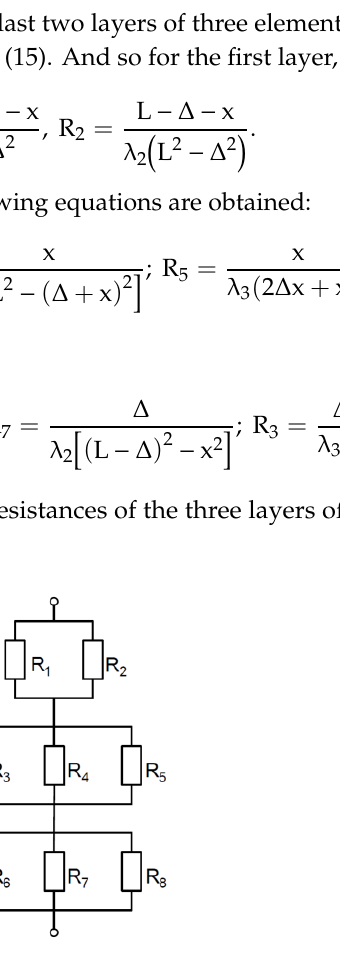
Figure 5. Diagram of connection of thermal resistances of separate elements at isothermal division.